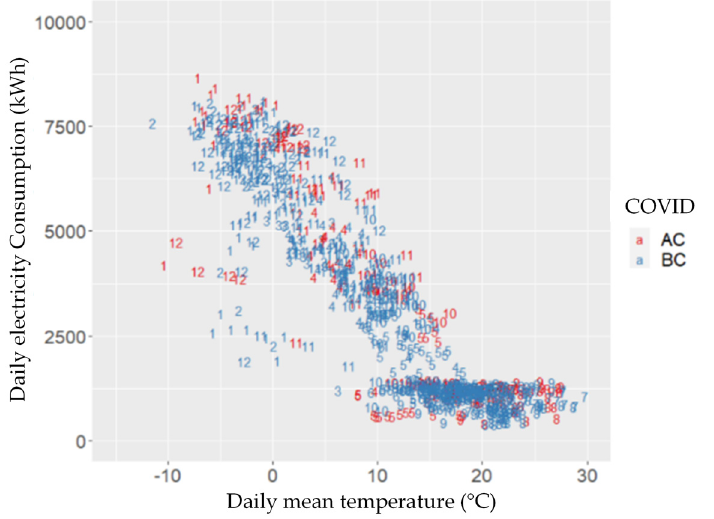
Figure 9. Relationship between daily energy consumption and outdoor temperature at High School A.